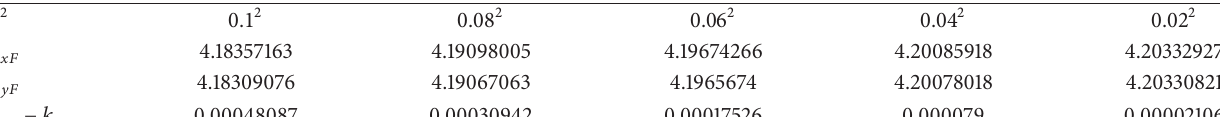
Table 1: Fermi momentums 𝑘 𝑥𝐹 and 𝑘 𝑦𝐹 with samples of 𝑎 2 for 𝑎 2 > 0 .